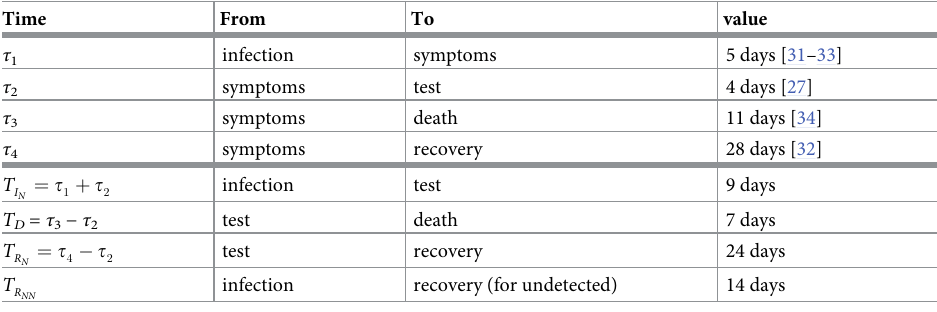
Table 1. Values of the transition times used in the SI 2 R 2 D model a . Time From To value infection symptoms 5 days [31–33]